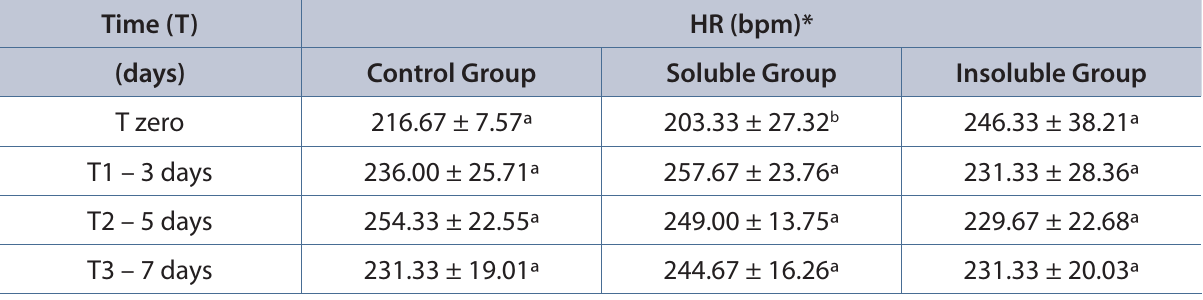
Coefficient of variation = 10.42% *Means followed by same letters do not statistically differ among the times (columns), according to analysis of variance and SNK test (p <